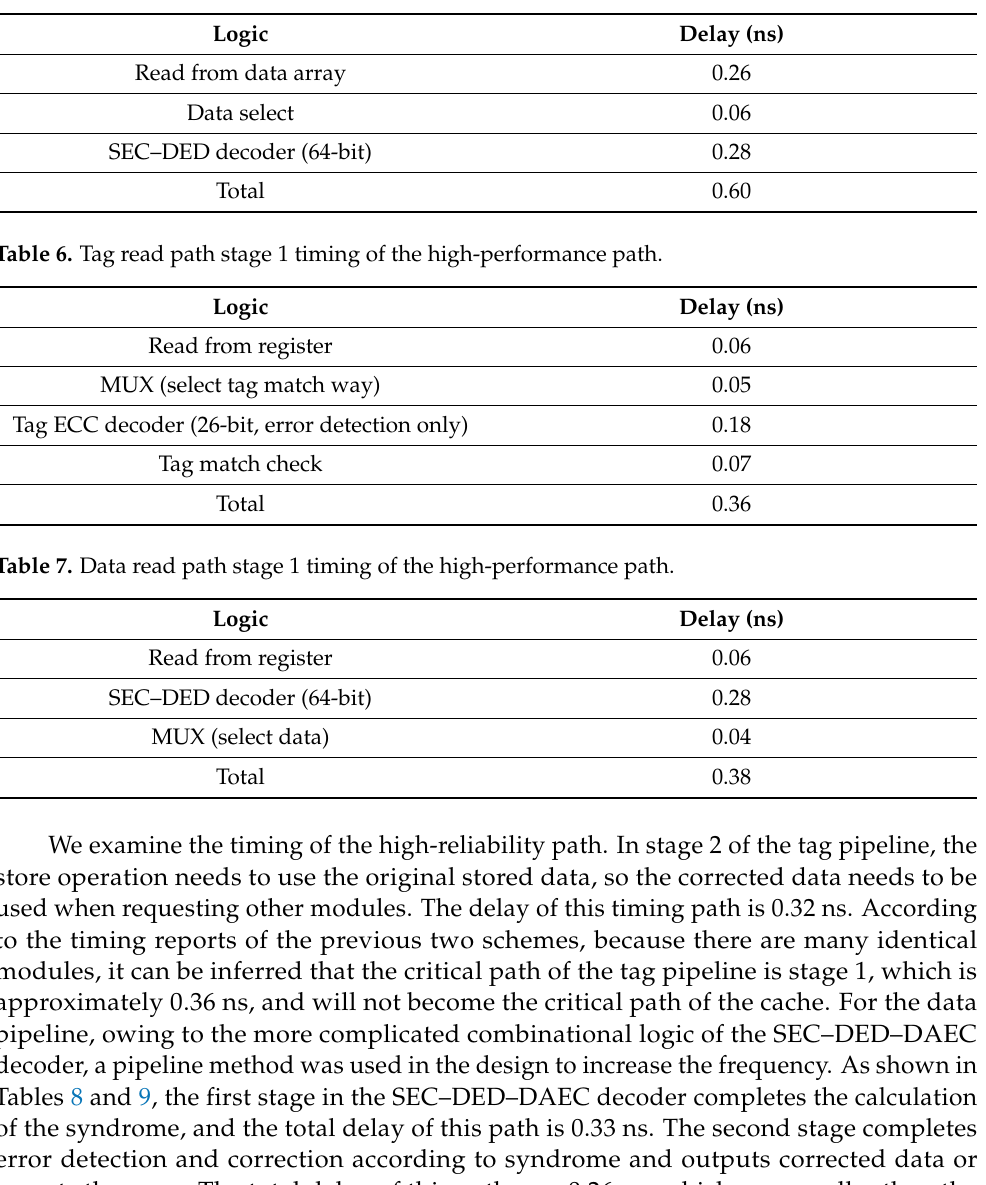
Table 5. Data read path timing of the conventional design scheme.